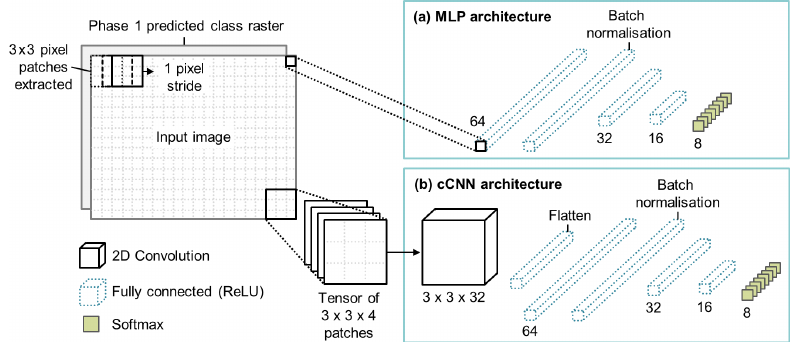
Figure 6. (a) Architecture of phase two multilayer perceptron used for pixel-based classification. (b) Architecture of the cCNN used in phase two for patch-based pixel-level classification. Patches are extracted from the input image with a stride of one pixel, assigned a class label according to the class raster produced in phase one, and compiled into 4D tensors which are then fed into the cCNN. An example of a 3 × 3 patch is shown in this diagram which uses an architecture with a single 2D convolutional layer with 32 3 × 3 filters. The convolutional layer feeds into a fully connected network like that of the MLP for class